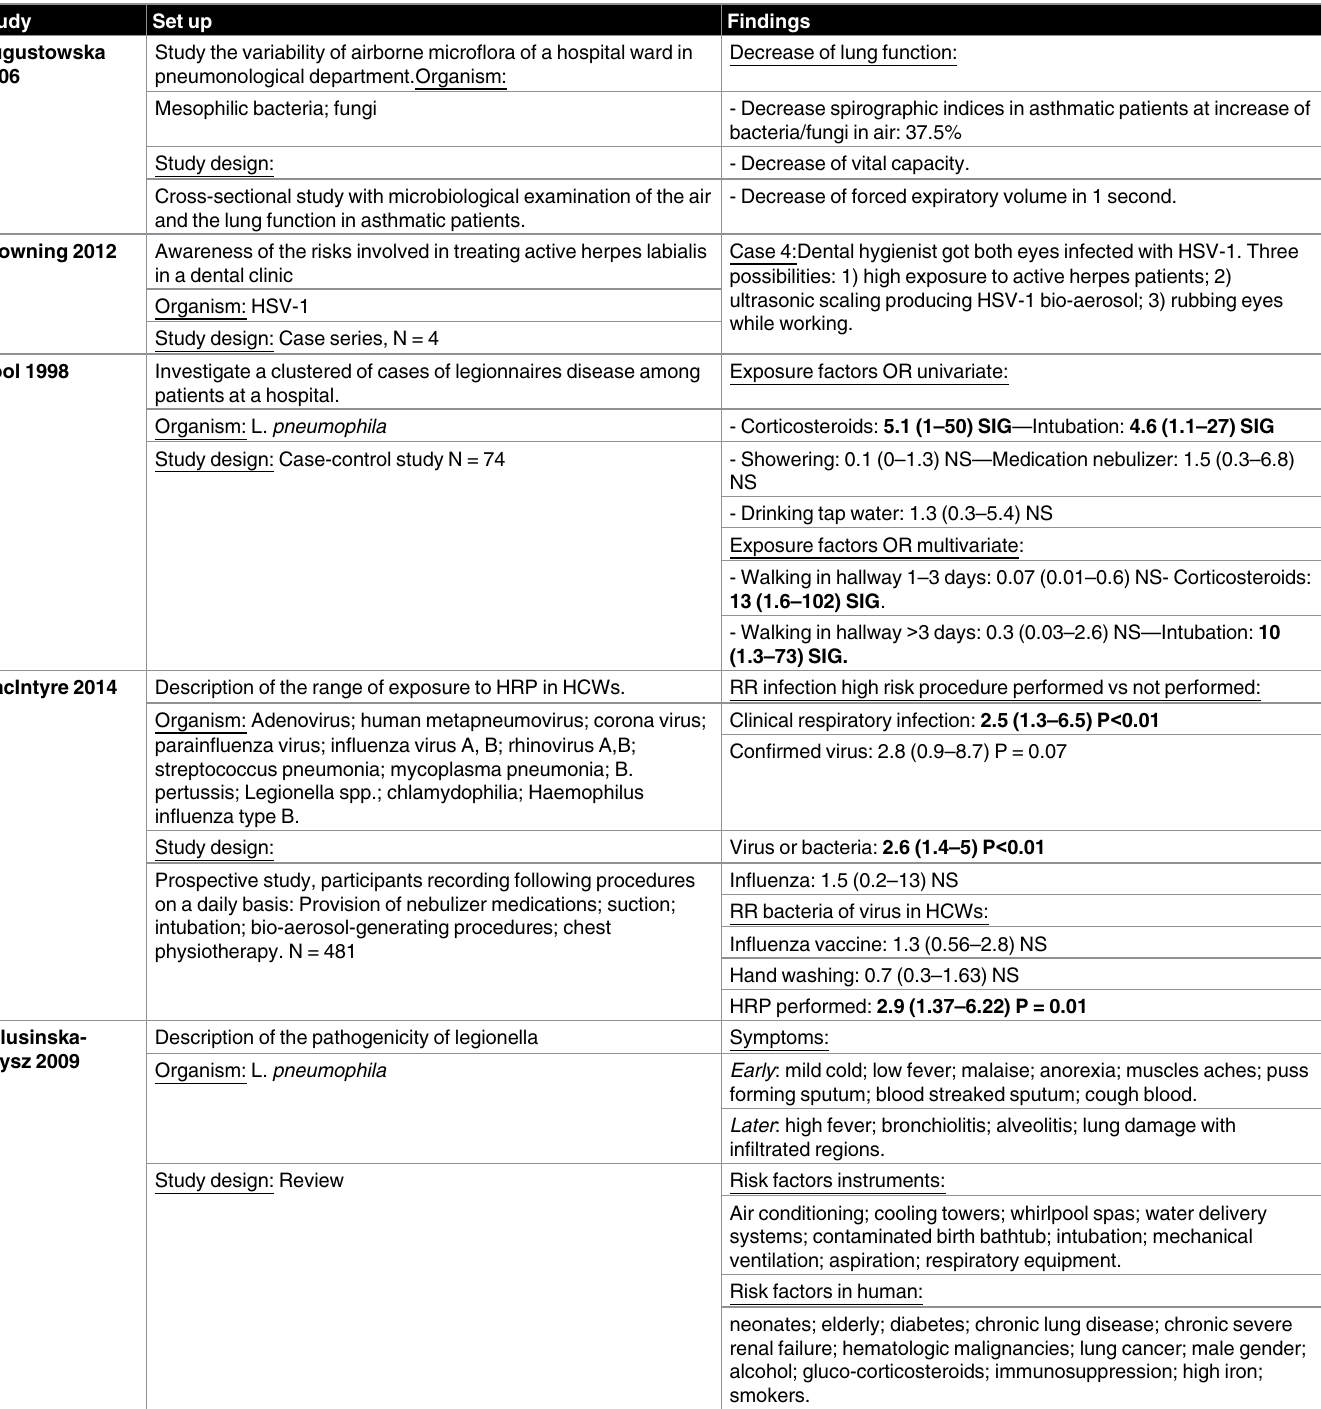
Table 5. Study characteristics hazard in healthcare and the dental